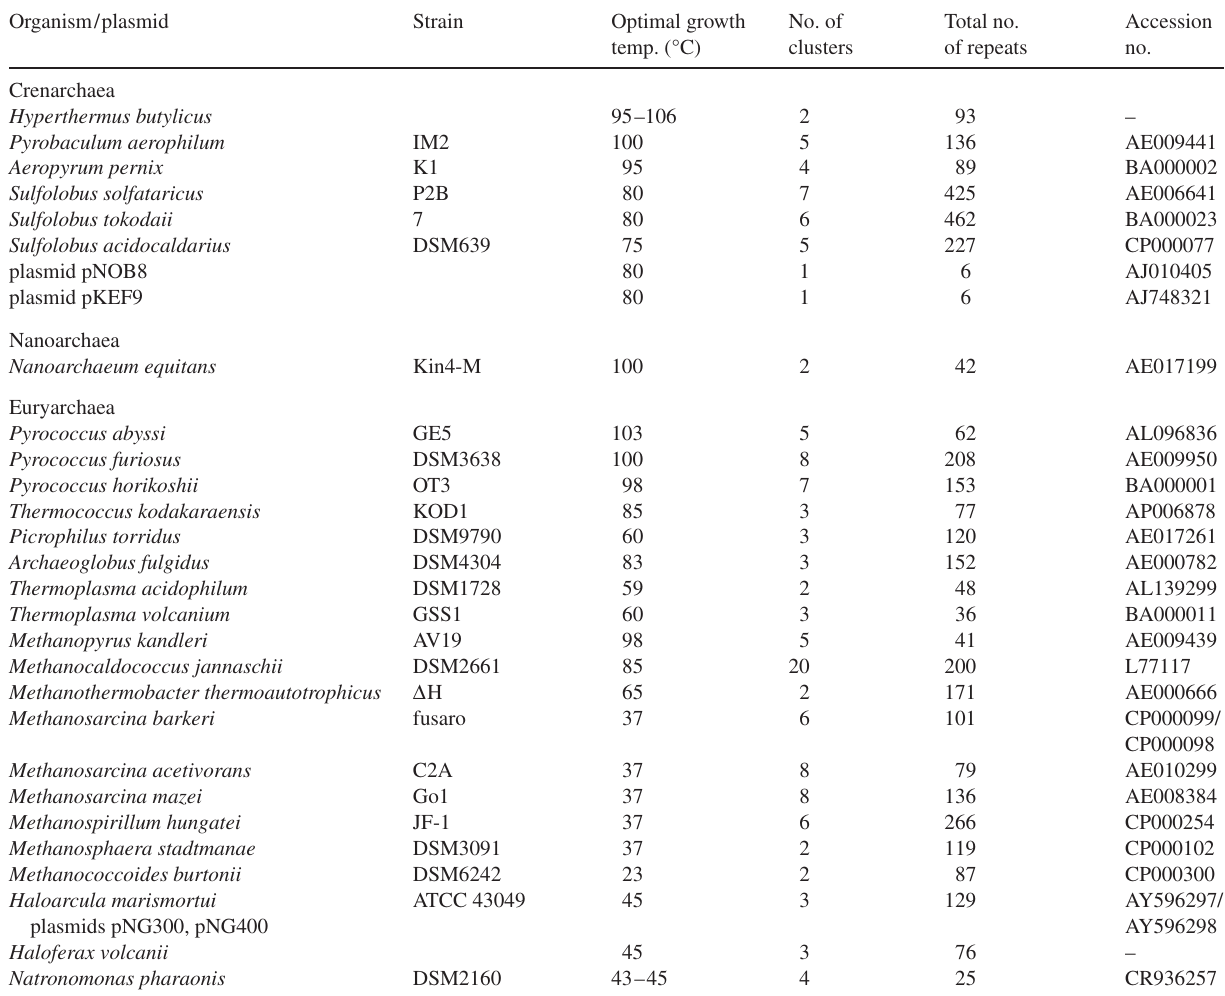
Table 1. Summary of properties of the archaeal chromosomal and plasmid clusters. Organism/plasmid Strain Optimal growth No. of Total no. Accession temp. (°C) clusters of repeats